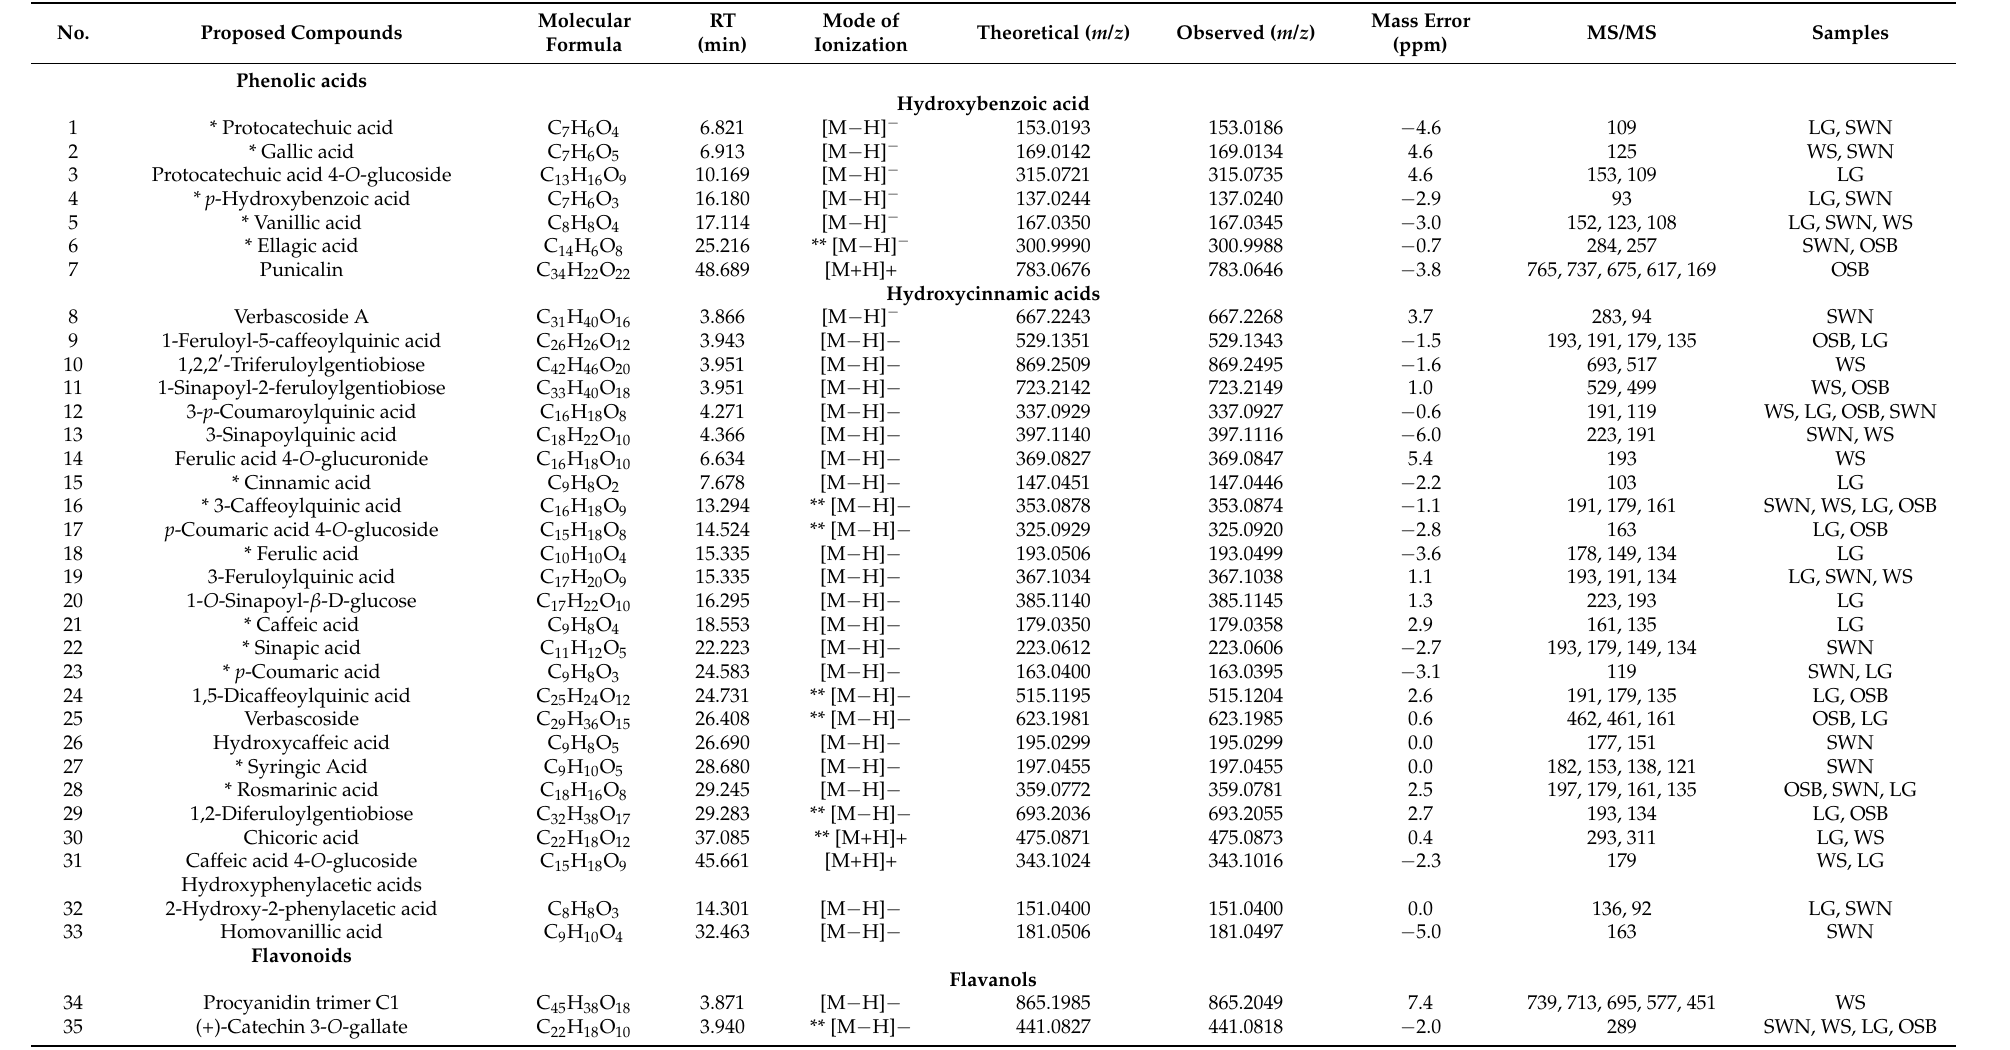
Table 3. LC-ESI-QTOF-MS/MS Identification of Phenolic Metabolites from Australian Native